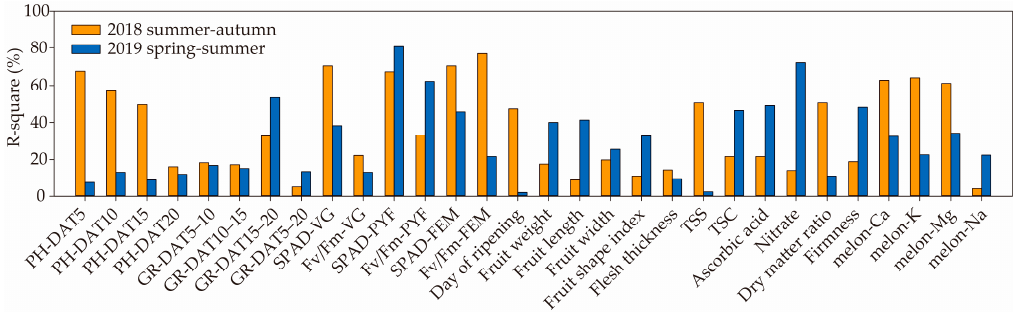
Figure 6. Regression coefficients (R-square values) of the best-subset regression comparing each plant growth and fruit characteristics of netted melon to nutrient characteristics of the hydroponic solutions from Experiment I and II. PH: plant height; GR: growth rate; TSS: total soluble solid; TSC: total salt content; DAT: number of days after transplanting; VG: vegetative growth; PYF: pollinated young fruit; and FEM: fruit enlargement and maturation.